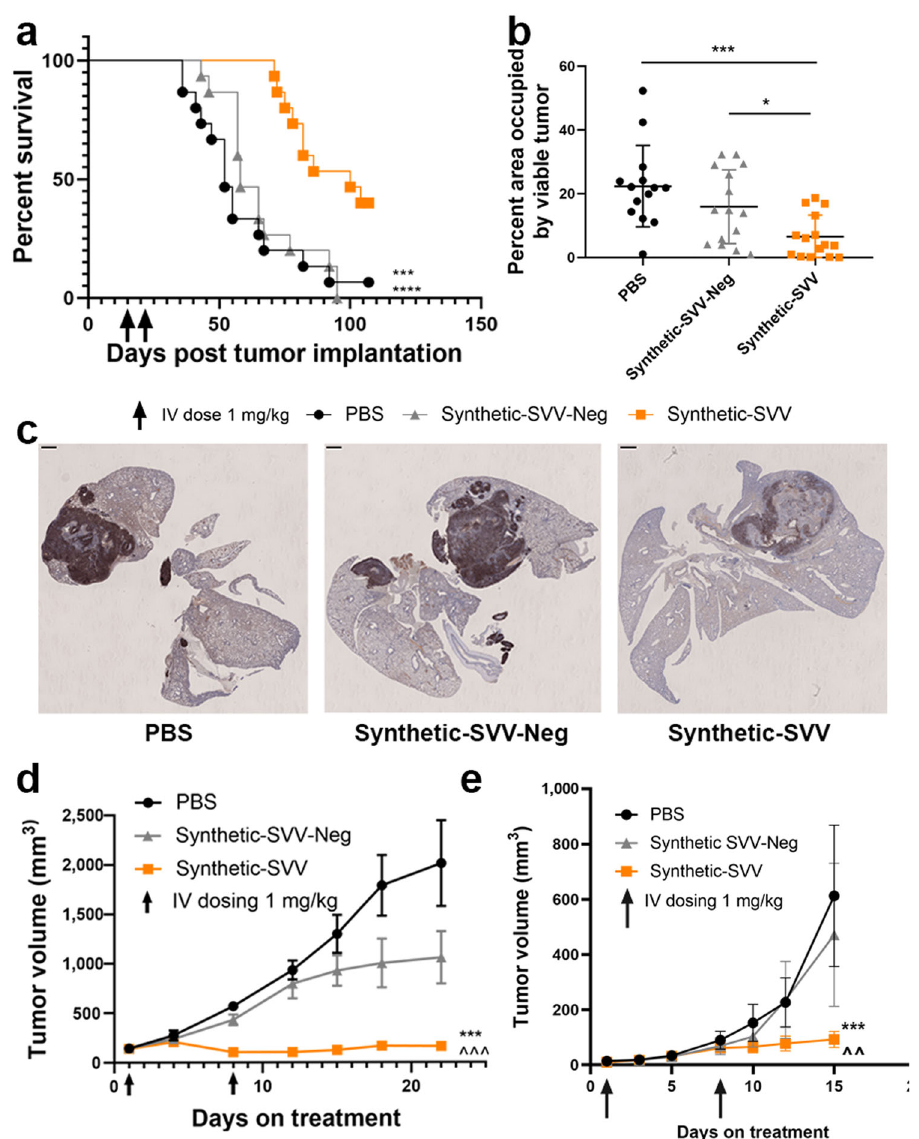
Fig. 4 | Synthetic-SVV treatment is ef fi cacious and prolongs survival in an orthotopic SCLC model. a – c NCI-H82 tumors were orthotopically implanted in athymic nude mice. Animals were dosed either with PBS, 1.0mg/kg Synthetic-SVV- Neg, or 1.0 mg/kg Synthetic-SVV on Days 15 and 22 post tumor inoculation ( n =15 per group). a Survival analysis was assessed using log-rank (Mantel – Cox) test, *** p =0.003; **** p <0.0001 vs. Synthetic-SVV. b Morphometric analysis of hDLL3 positiveareaofpulmonaryandextrapulmonarytissueoccupiedbyviabletumorin lungs collected from mice 10 days post-treatment. Statistical signi fi cance was determined using two-tailed paired T-test, * p =0.011; *** p =0.0003. c Representative images of hDLL3 staining asdetermined in 15 individualsamples/ treatment arm. Scale bars in the upper left are 1000 µ m. d NOD/SCID mice were